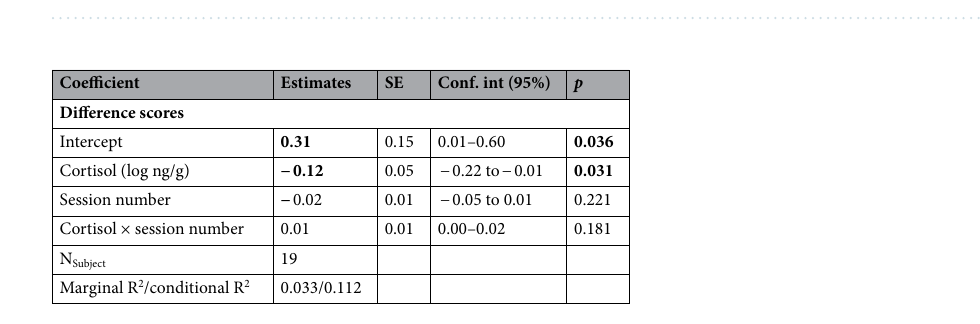
Figure 2. Bar graph of average overall difference score throughout 15 sessions for each individual. Positive scores indicate better performance on high-pressure trials (HPTs) than low-pressure trials (LPTs) (thriving under pressure); negative scores indicate worse performance on HPTs than LPTs (choking under pressure). Error bars represent the standard error of the mean (SE). • p < 0.10, * p < 0.05, ** p < 0.01; results of non-parametric Wilcoxan signed rank tests.